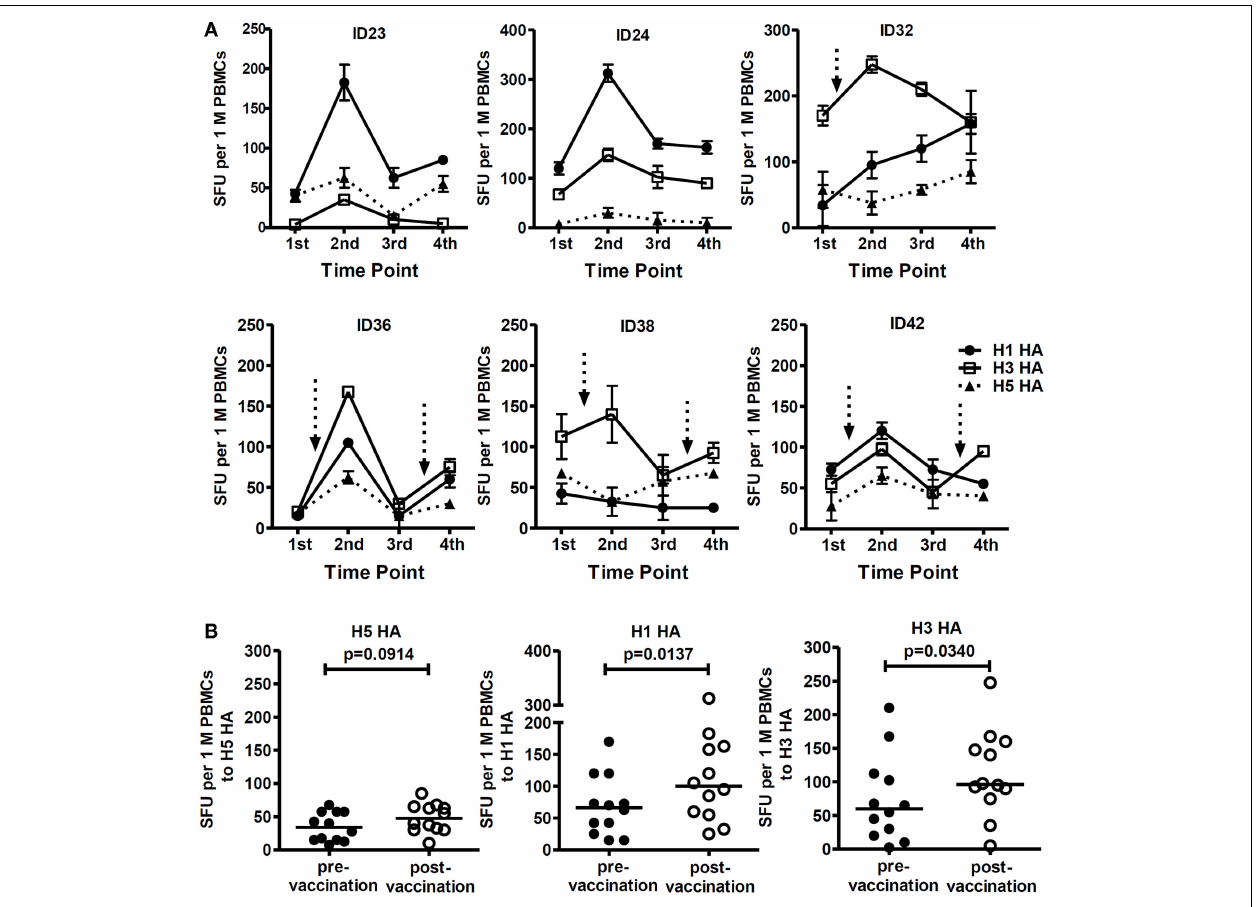
FIGURE 4 | T cell responses to seasonal influenza HA peptides were elevated after the first and second dose of the pLAIV . (A) T cell responses to H1 HA, H3 HA, and H5 HA peptides at all four time-points in six study subjects. n = 2 replicates; Arrows represent documented vaccine virus infection.